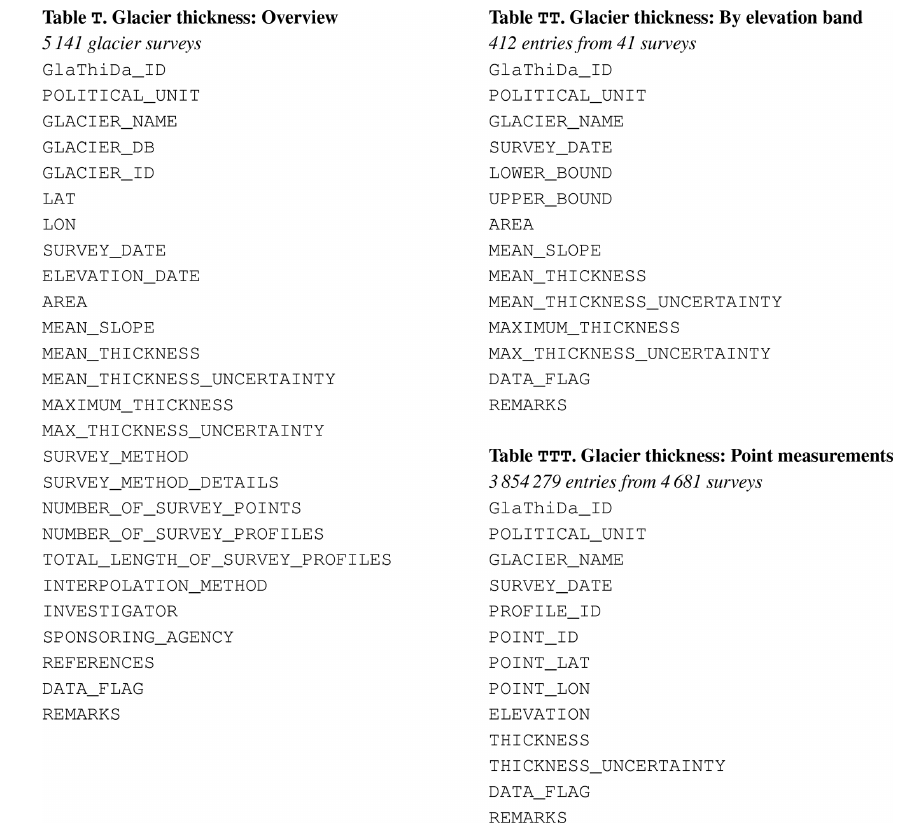
Figure 2. Fields and overall contents of the three database tables T , TT , and TTT . Detailed field descriptions are provided in the metadata file described in Sect. 2.2.2.